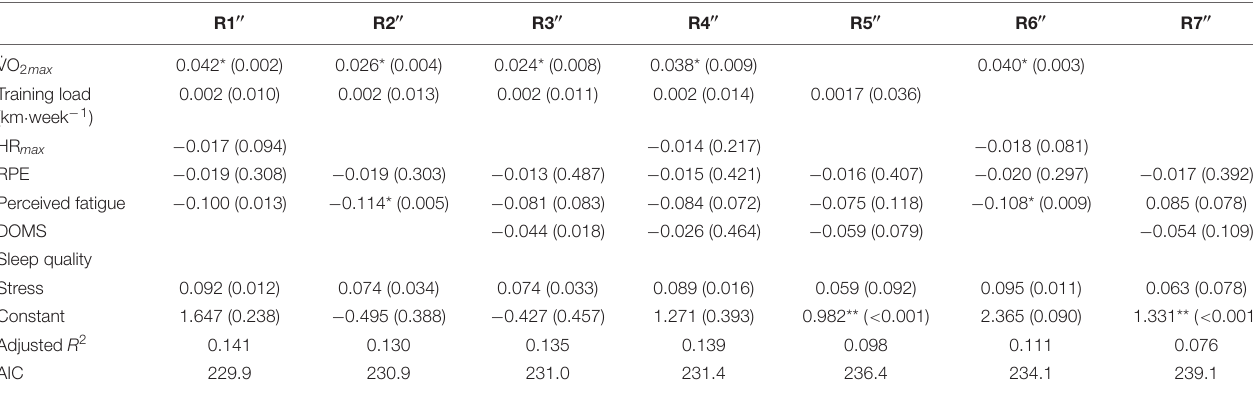
TABLE 4 | Linear coefficients, their corresponding p -values (in parentheses), adjusted R 2 coefficients, and Akaike information criterion (AIC) of the different linear multivariable mixed models tested to explain the difference between standing and supine LnRMSSD of